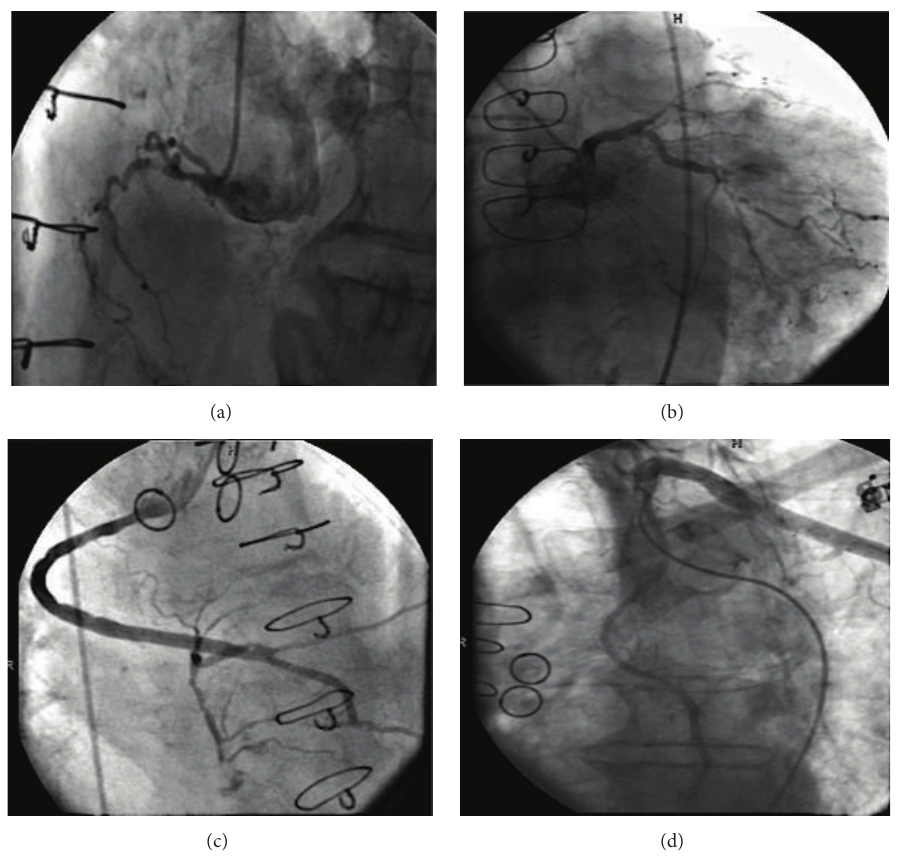
Figure 1: (a) Right coronary artery 100% occluded in the proximal segment. (b) Left anterior descending with 99% ostial and 100% mid occlusion and circumflex 99% distal occlusion. (c) Sequential vein graft to right posterolateral and posterior descending artery with 40% proximal disease. (d) Left internal mammary artery graft to distal left anterior descending widely